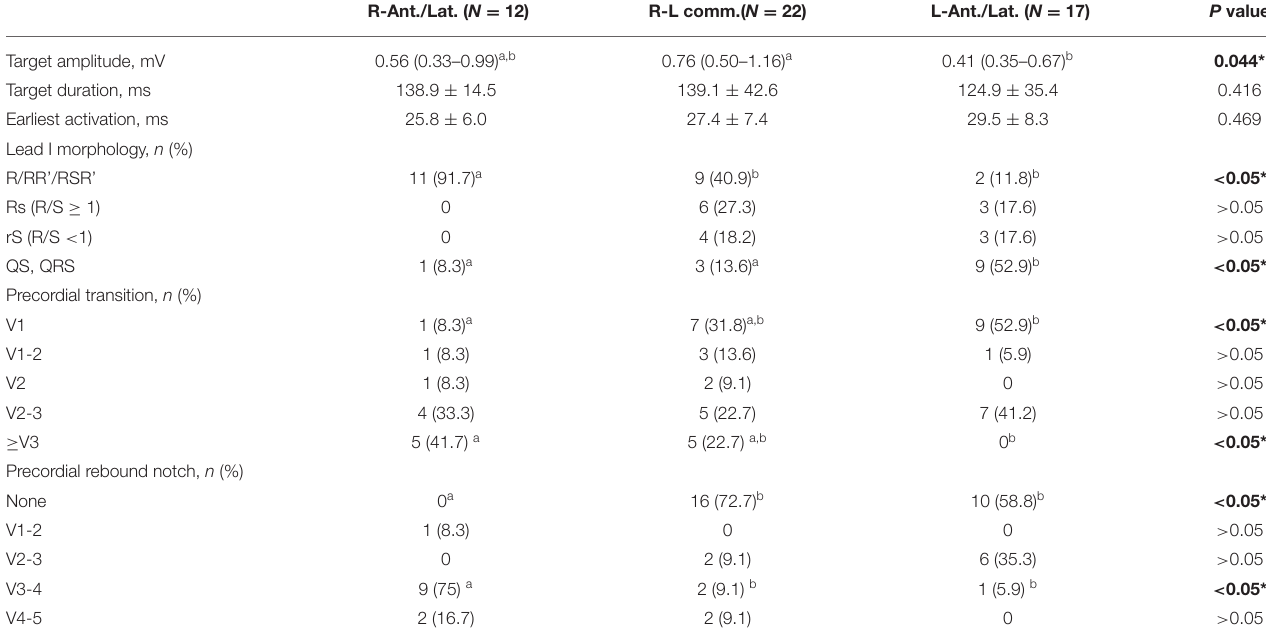
TABLE 2 | Bipolar electrogram and ECG characteristics during ventricular arrhythmias. R-Ant./Lat. ( N =